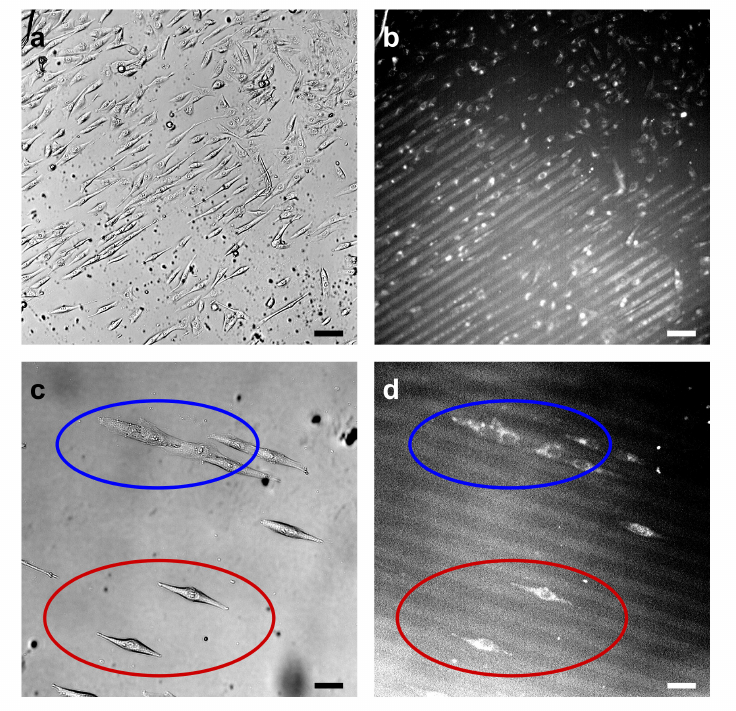
Figure 3. Optical microscopy images of MG-63 cells after 24h adhesion time on glass with molecule stripe landscapes. The scalebars in the bottom right corner show 100 µ m or 50 µ m for images ( a , b ) and ( c , d ), respectively. ( a ) Brightfield image of adhered cells. Most cells escpecially the ones in the lower half of the image orient diagonally and adopt a spindle shape. ( b ) Corresponding auto-fluorescence image, obtained by using a GFP-filtercube. The bright stripes (indicating NH 2 -terminated dendrimer layers) are oriented in the same direction as the cells. At spots where the stripe pattern is absent (top right) the cells orient randomly and do not necessarily take on a spindle shape. ( c ) Brightfield image of adhered MG-63 cells on BSA µ CP glass. The cell clusters (marked in blue) are oriented in the same way as the separated cells (marked in red). However, it is visible that the adhesion area is not so well defined for the cell-clusters. ( d ) Corresponding auto-fluorescence image. The separated cells orient along the bright BSA stripes, but adhere on the dark glass-stripes. In case of the cell clusters (marked in blue), orientation and confinement onto the glass site is largely